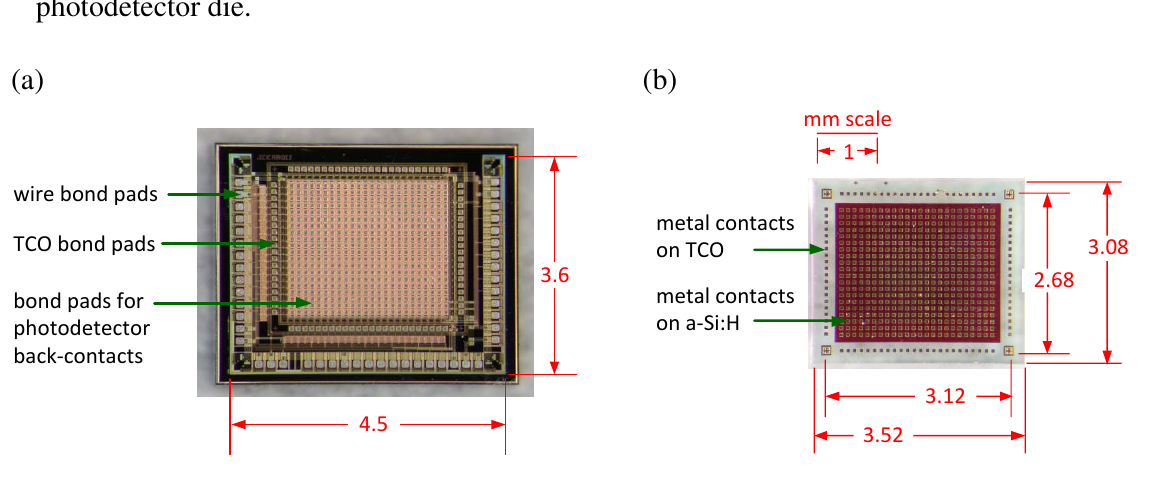
Figure 3. The VI-CMOS prototype in Figure 1(b) is composed of (a) a CMOS die and (b) a photodetector